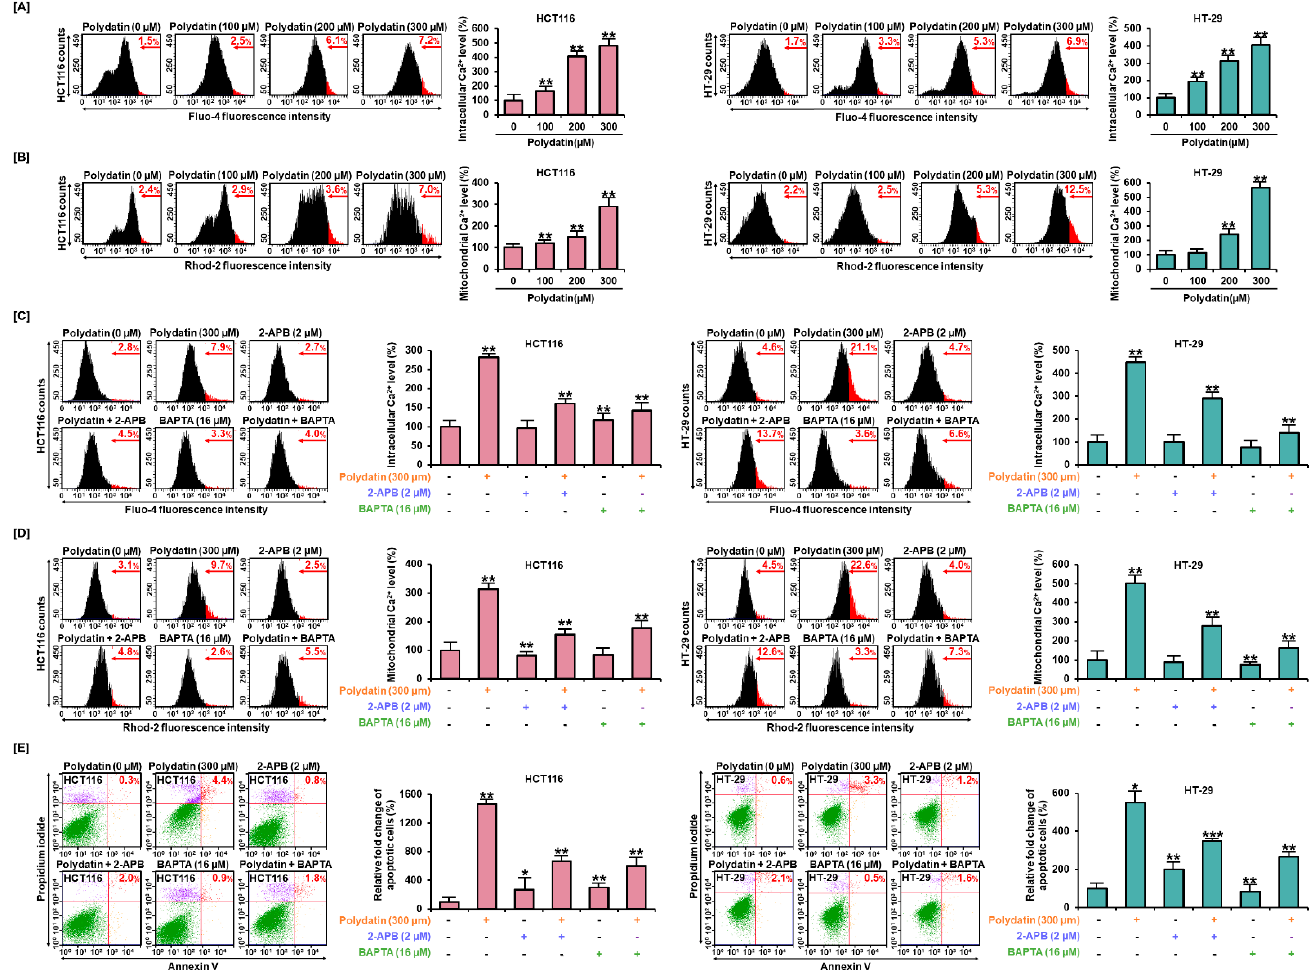
Figure 3. Polydatin caused the disturbance of calcium regulation and apoptosis in HCT116 and HT-29 cells. ( A ) In response to polydatin, the cytosol calcium concentrations in colon cancer cells were evaluated by flow cytometry analysis with Fluo-4 dye. ( B ) The colon cancer cells treated with polydatin were stained with Rhod-2 dye to analyze mitochondrial calcium concentrations. ( C , D ) Effects of polydatin with specific calcium-channel inhibitors, 2-APB (IP3R), BAPTA/AM (intracellular calcium), ( C ) cytosol, and ( D ) mitochondrial calcium levels in HCT116 and HT-29 cells. ( E ) Effects of polydatin with each calcium-channel inhibitor on apoptosis in HCT116 and HT-29 cells by Annexin V and PI staining. The asterisks indicate statistical significance of the effect of treatment (* p < 0.05, ** p < 0.01, and *** p < 0.001).